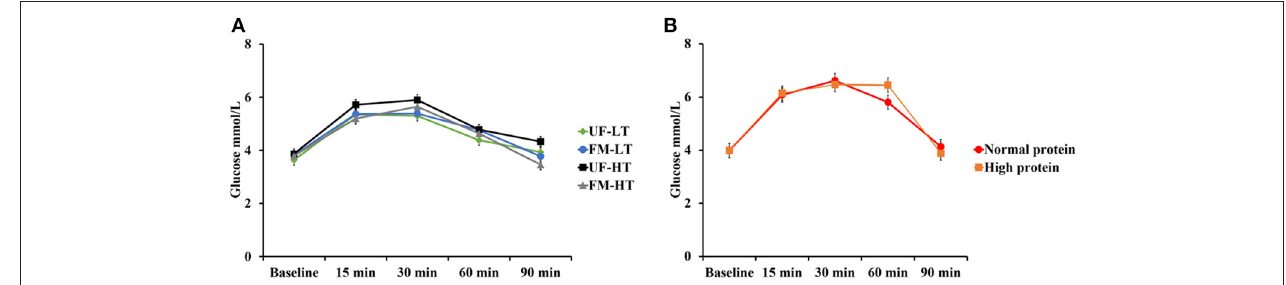
Table 1 . No significant effect ( P > 0.05) of dietary protein content (NP vs. HP) was observed on BCS or BW after 7 days of feeding